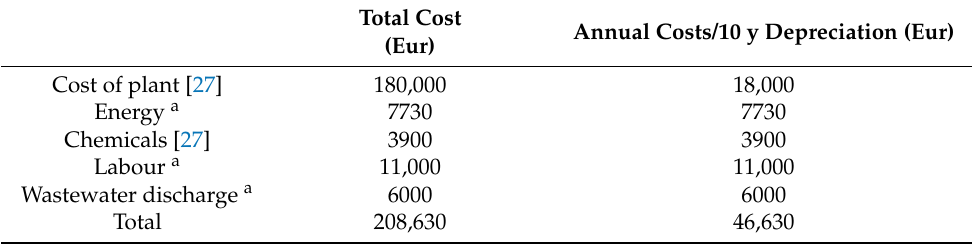
Table 5. Cost Table 5. Cost estimation.